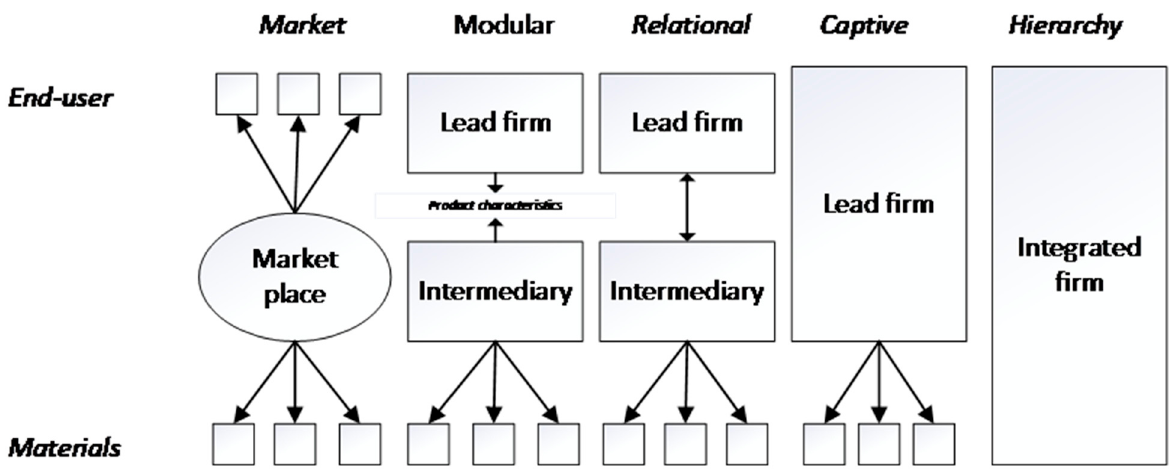
Figure 1. Five types of value chain governance (Based on Gereffi et al. [11]).